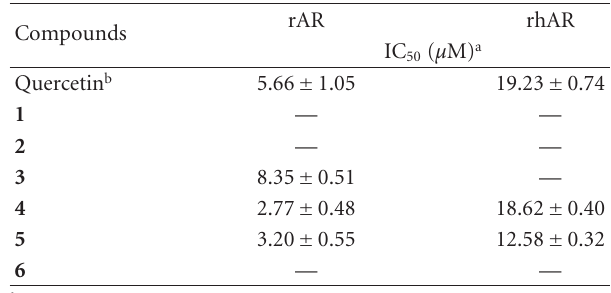
a Inhibition rates were calculated as percentages with respect to the control value. The IC 50 values of each sample were estimated from the least-squares regression line of the logarithmic concentration plotted against